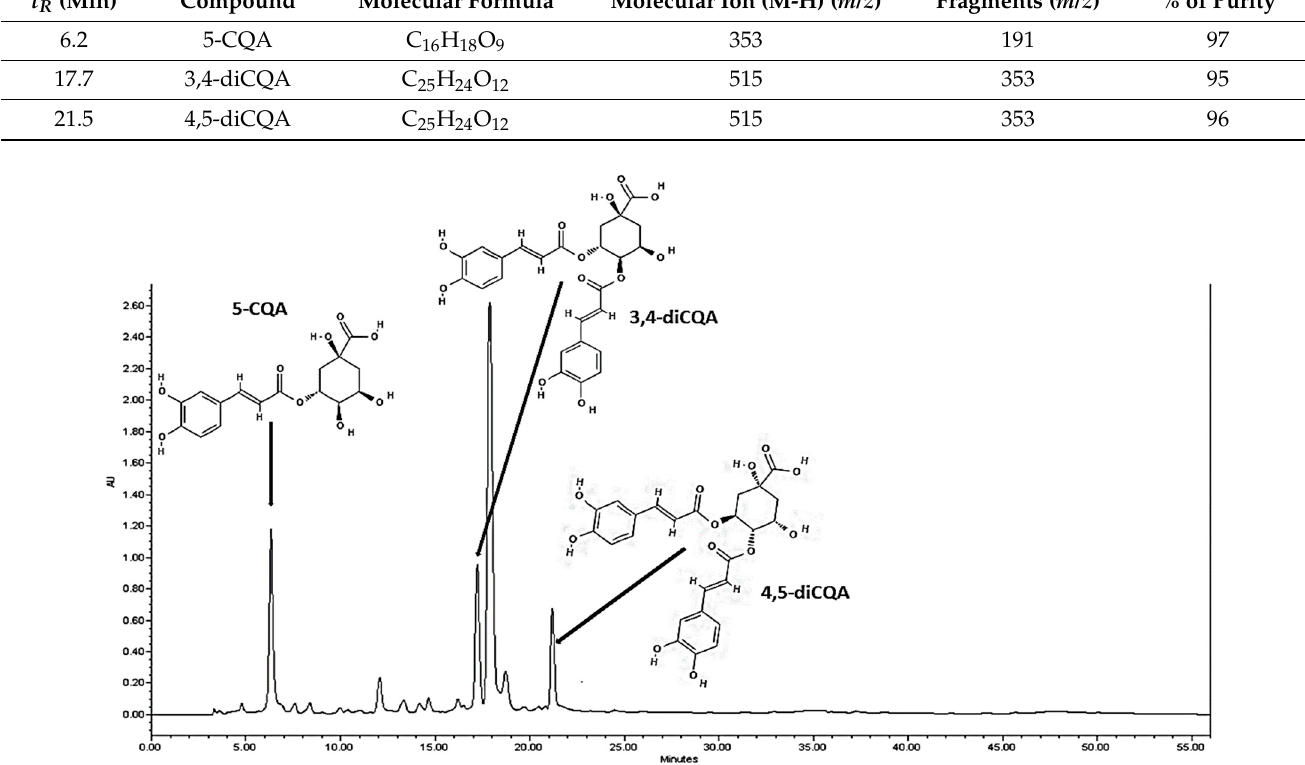
Figure 2. Chromatogram of CQA-derivatives from PSP and detected 320 nm. Table 1. CQA-derivatives in PSP identified by mass spectrometry (HPLC-MS)